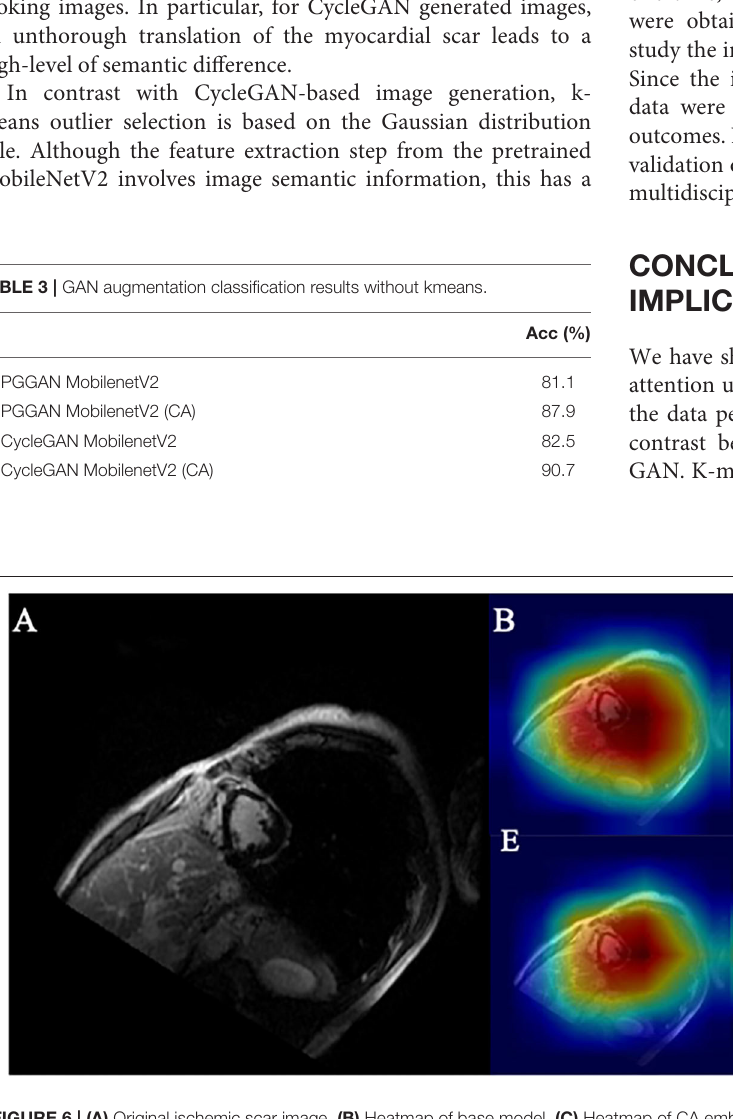
Frontiers in Cardiovascular Medicine |